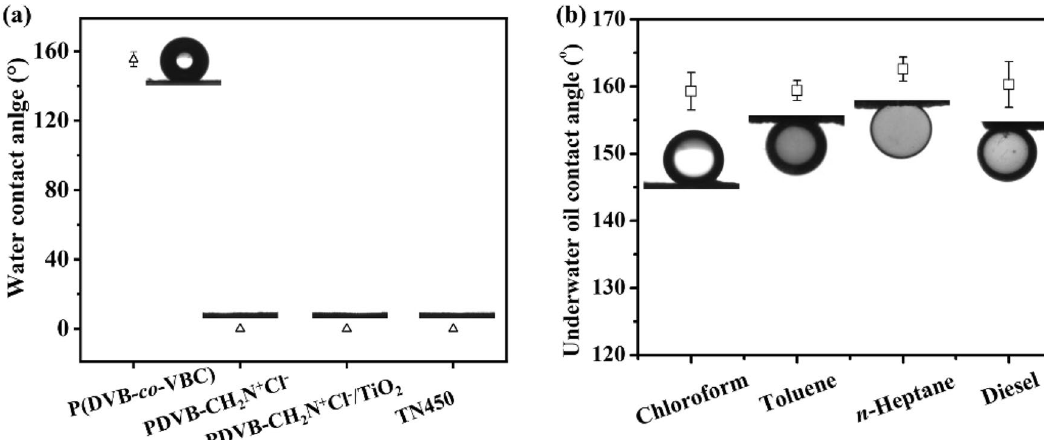
Figure 5. ( a ) The water contact angle versus surface chemistry of the coated mesh; ( b ) Under water oil contact angle of TN450 coated mesh (model oil: chloroform, toluene, n-heptane, and